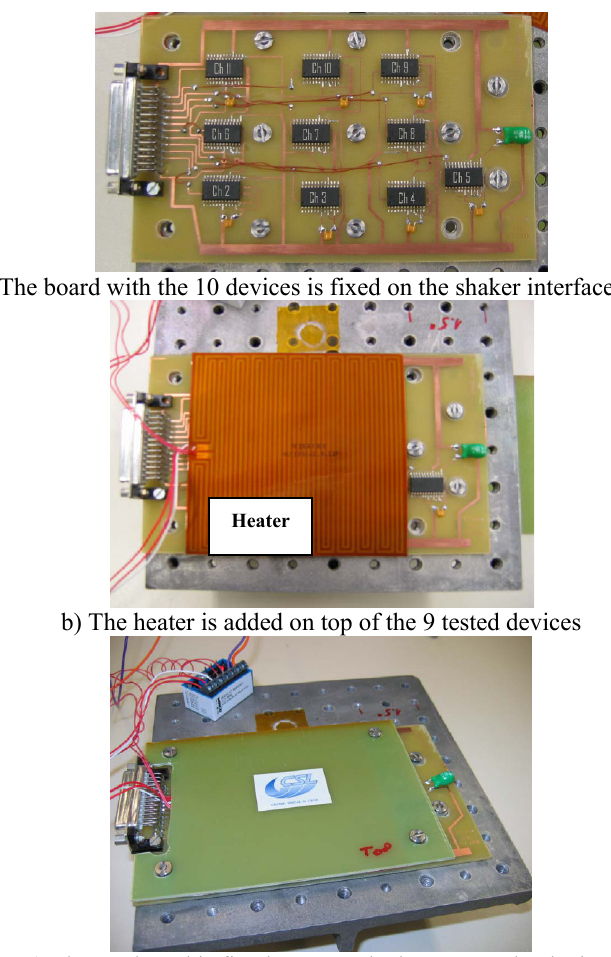
Figure 1. Experimental set-up for testing at vibration and